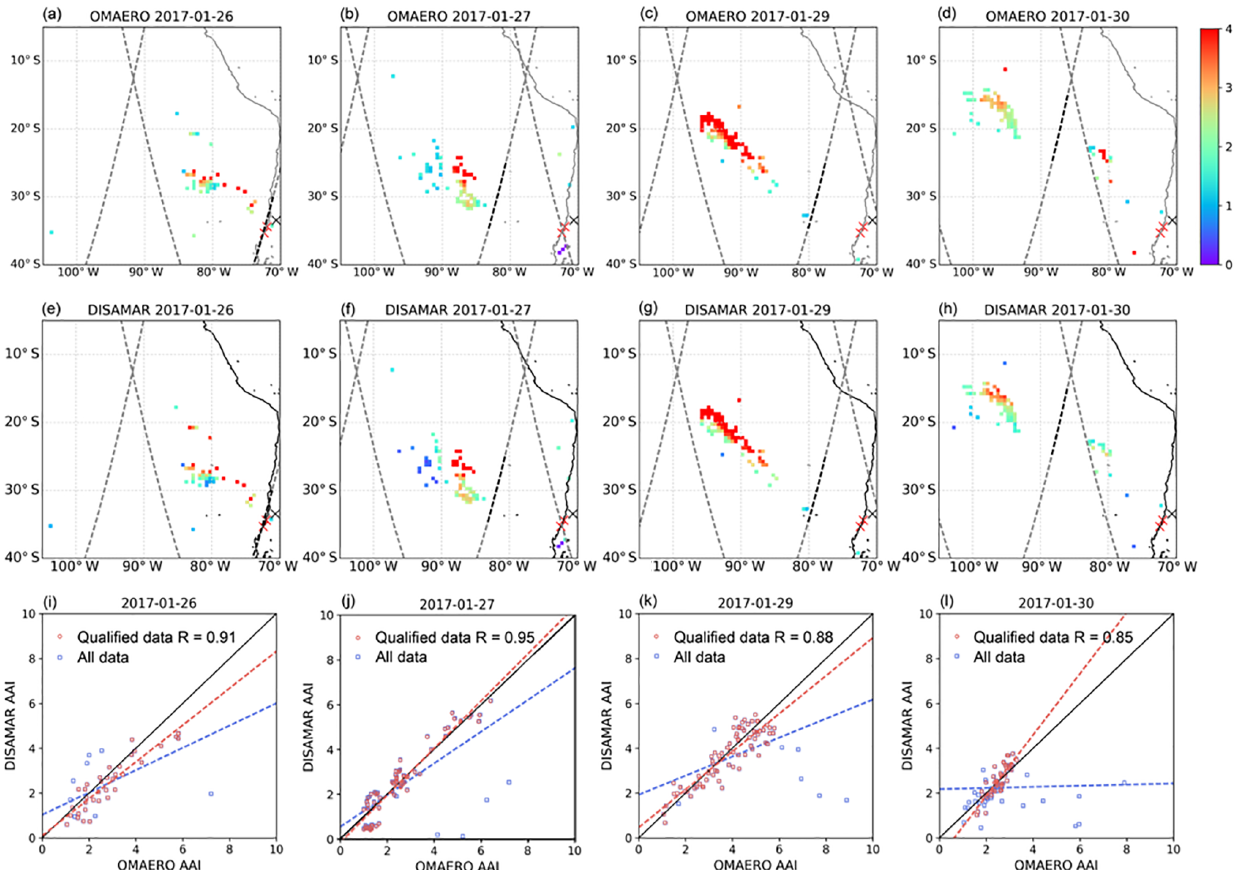
Figure 8. AAI from OMI observations (a–d) and DISAMAR simulations (e–h) of the Chile wildfires on 26, 27, 29 and 30 January 2017. The black and red cross symbols are the AERONET station and the main fire sources (Pichilemu 34.39 ◦ W, 72.00 ◦ S and Consititución 35.33 ◦ S, 72.42 ◦ W). The grey dashed line indicates the CALIOP overpasses in the region of interest, where the overpasses used to validate the plume height are marked by black dashed lines. The scatter plots (i–l) present the OMI observations against DISAMAR simulations for only qualified data (red dot) and all data (blue dot),